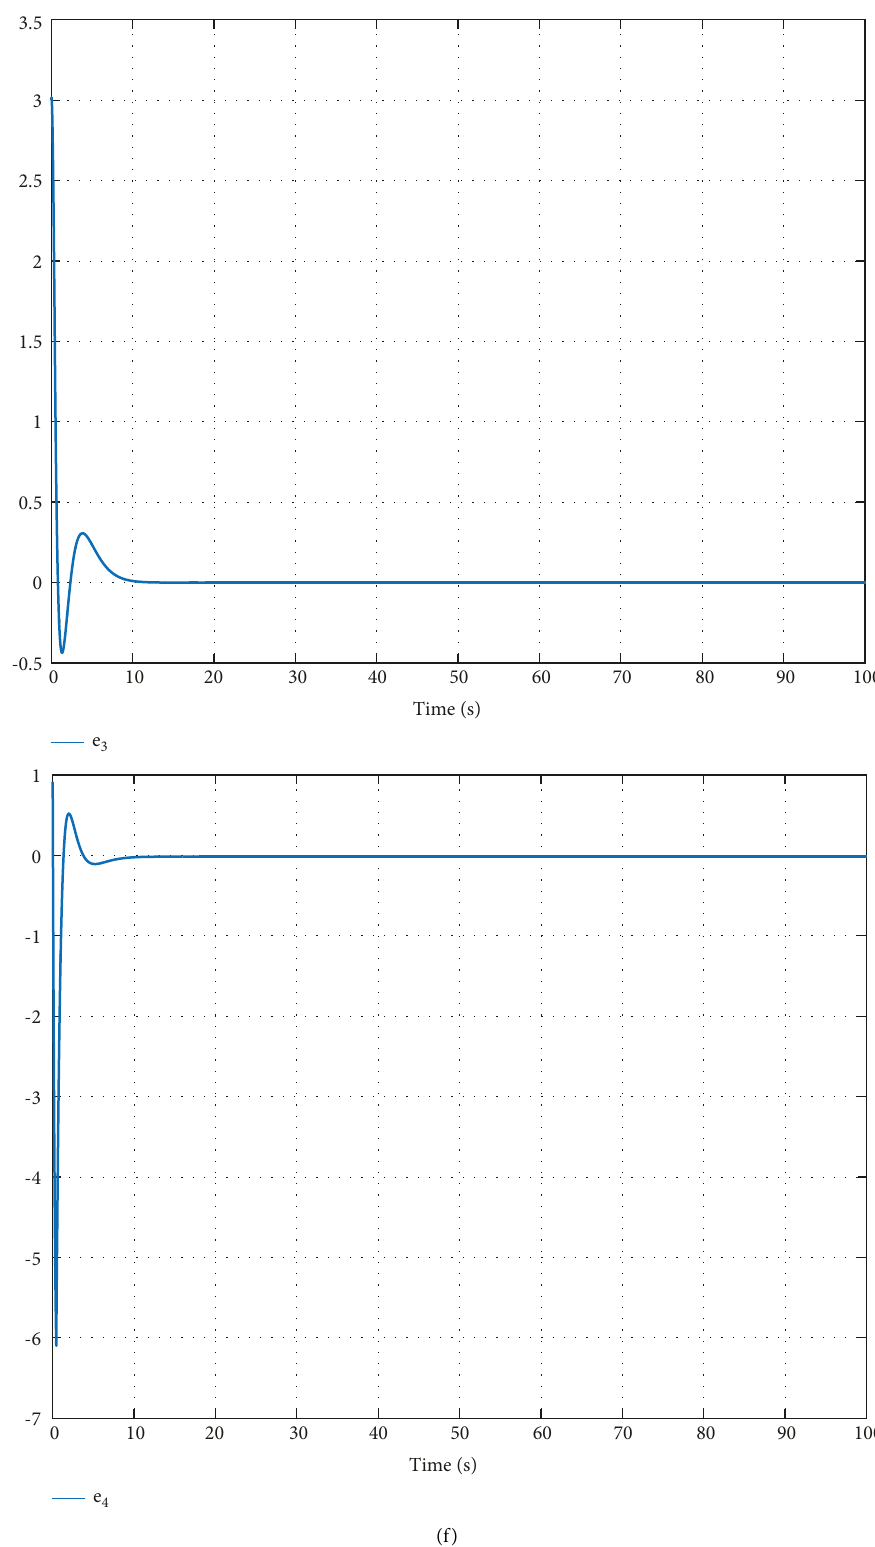
Figure 1: Synchronization of identical 4D hyperchaotic financial system. (a) Synchronization of interest rate corresponding to initial ( 0 ) , y ( 0 ) � ( 3 , − 2 )] . (b) Synchronization of investment demand corresponding to the initial condition condition [ x 1 1 ( 0 ) , y ( 0 ) � ( 1 , 3 )] . (c) Synchronization of price index corresponding to initial condition [ x [ x 2 2 of average profit margins corresponding to the initial condition [ x ,e , e , and e e 1 2 3 4